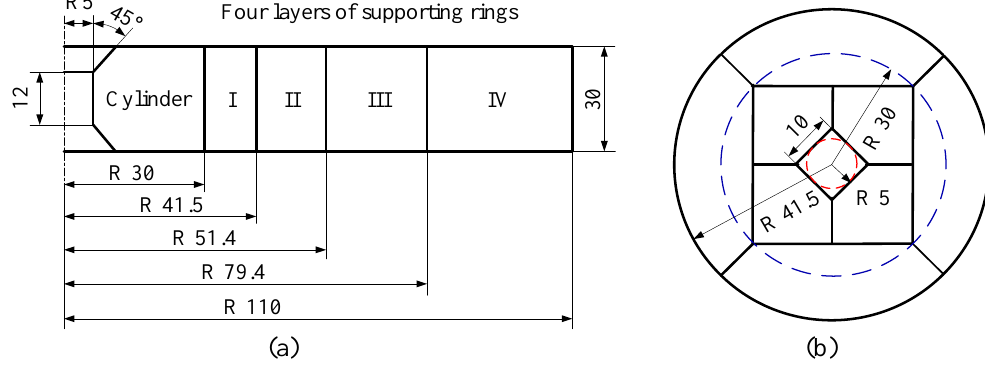
Figure 2. Geometric sizes of high-pressure dies: ( a ) BTD; and ( b ) split layers of DLSD.